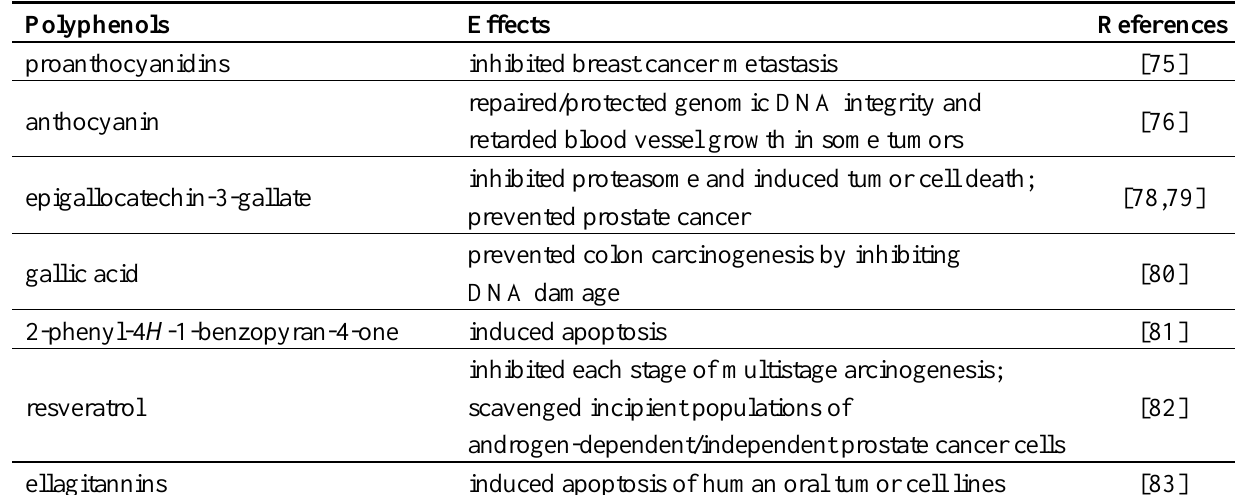
Table 2. Anticancer activities of some